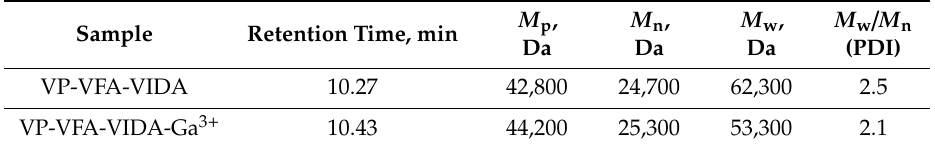
Table 1. Molecular masses and polydispersity characteristics of VP-VFA-VIDA copolymer and metal-polymer complex VP-VFA-VIDA-Ga 3 + determined by size exclusion